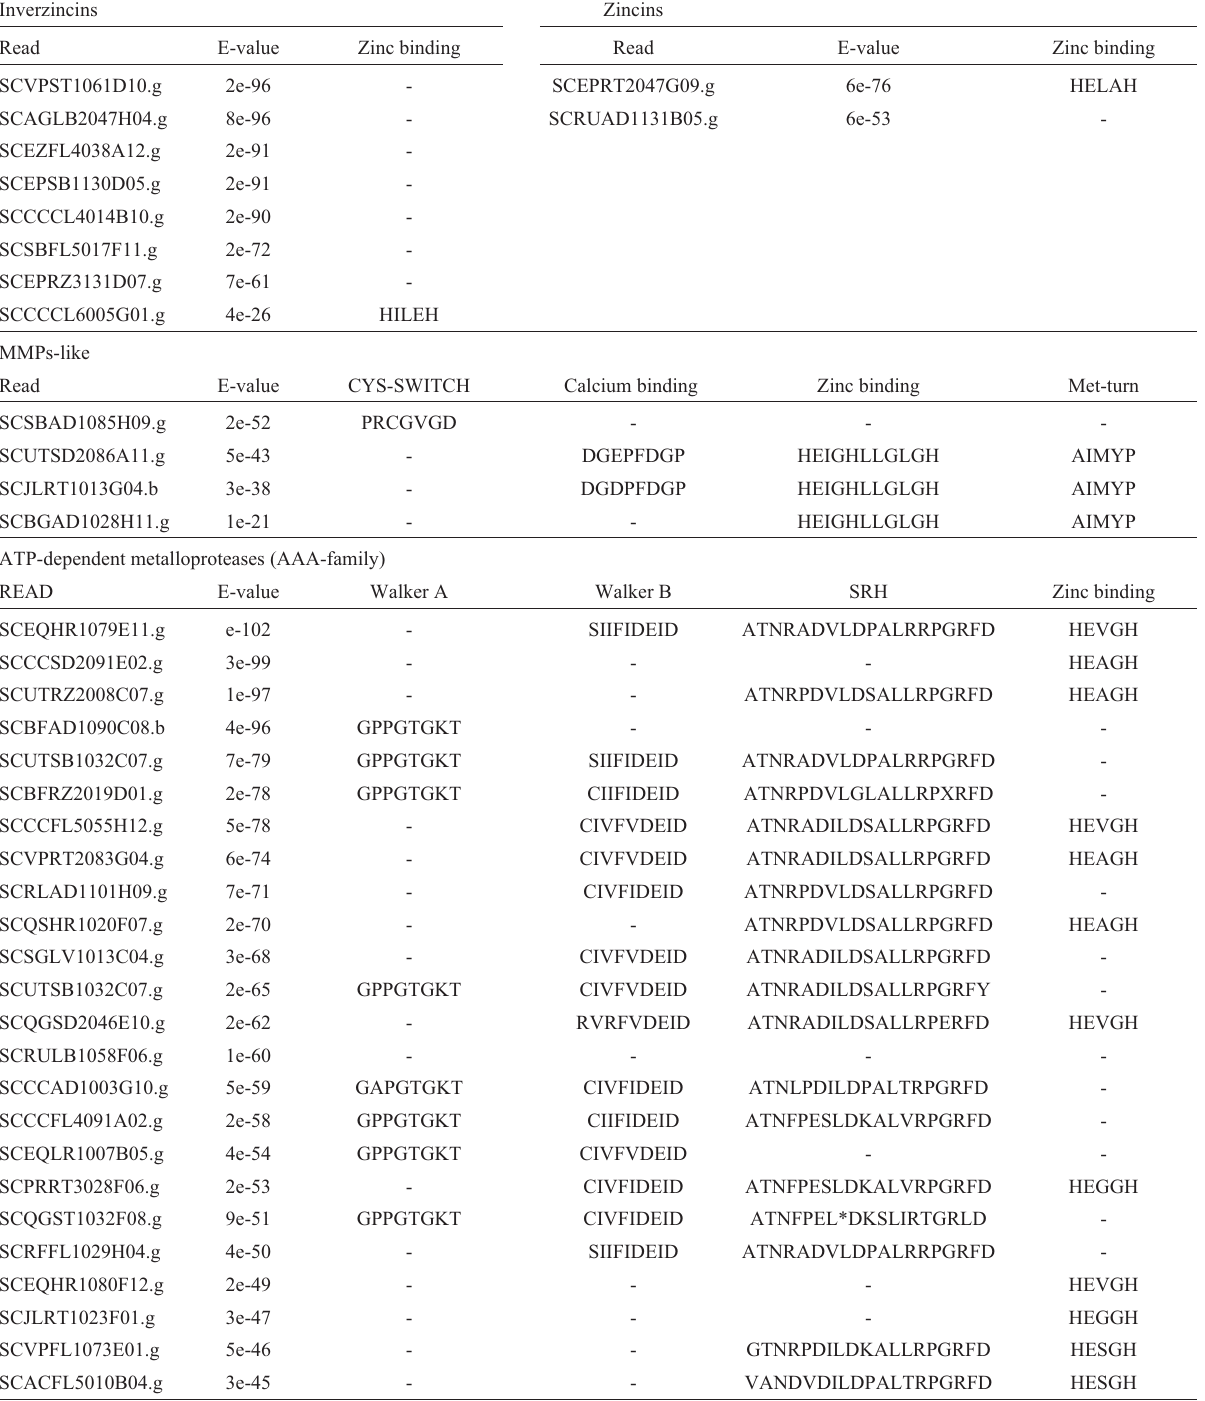
Table I - Classification of metalloprotease families and conserved motifs in